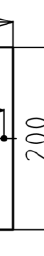
Fig. 1 . Measurement points .